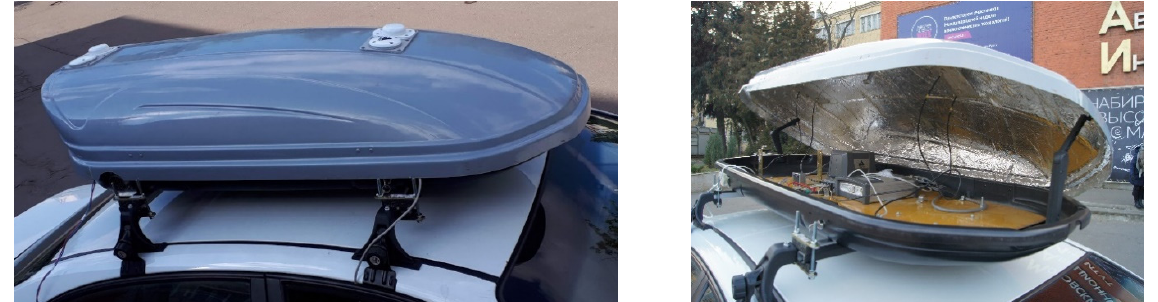
Figure 2. MAI Navigation System Car Testbed.